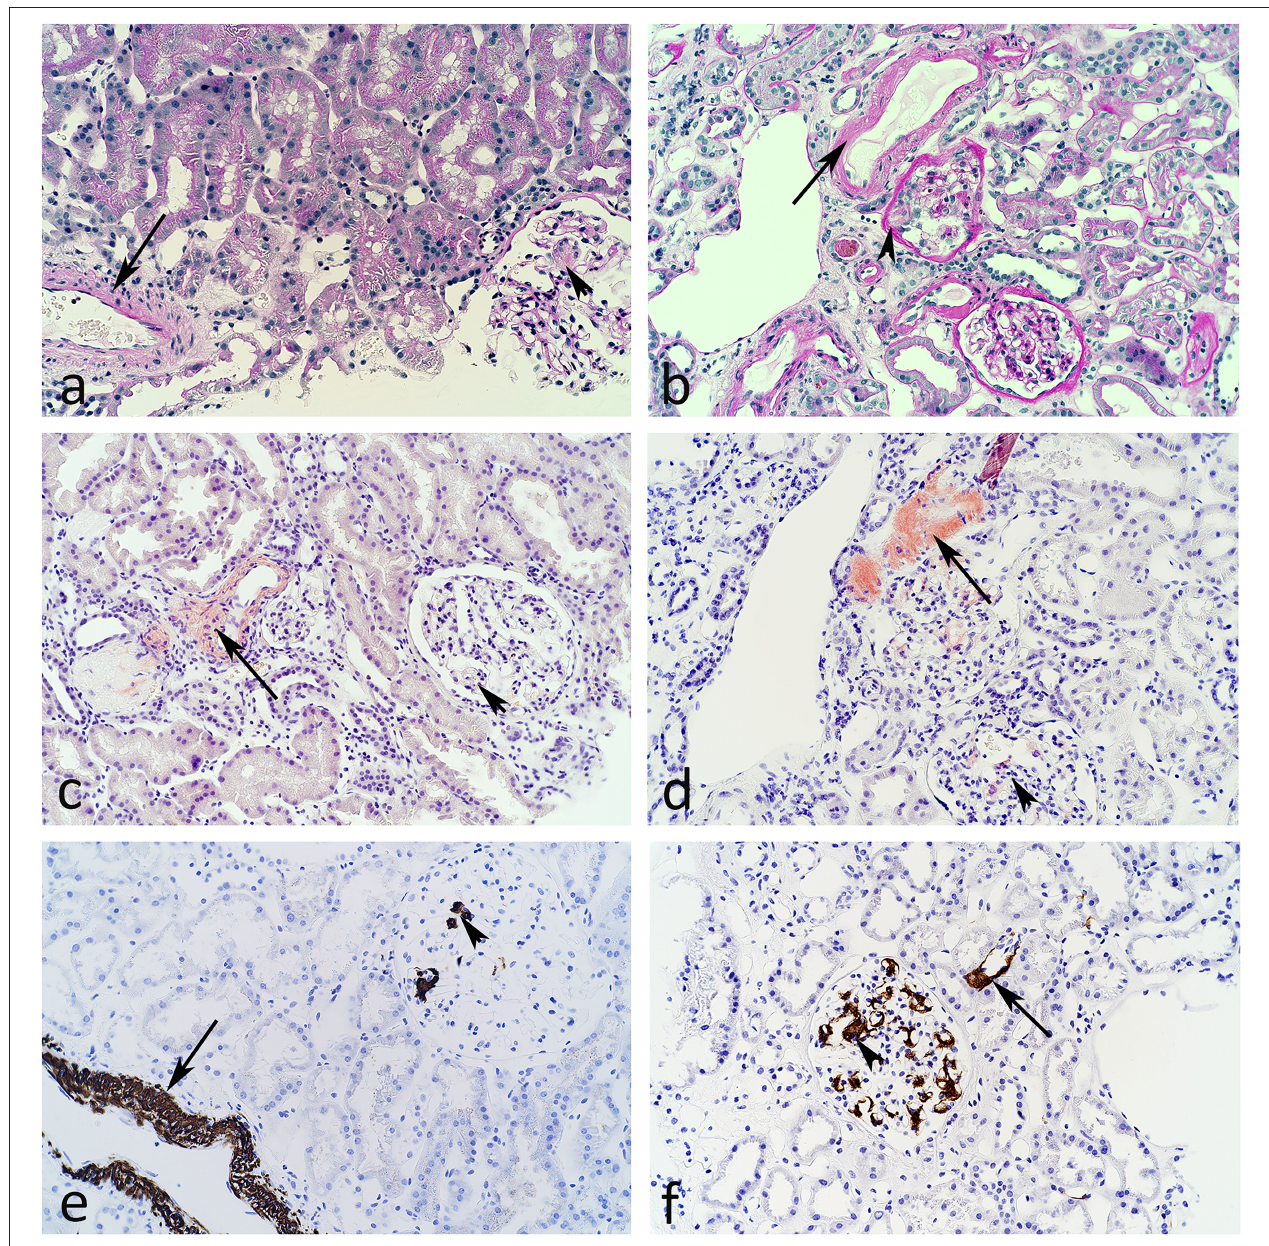
FIGURE 2 | Light microscopic images from the first (a,c,e) and the second (b,d,f) clinical case described. PAS stain (a,b) indicates deposition of minimal amorphous material in arteries (arrows) and a glomerulus (arrowhead) in panel (b) . Congo red stain (c,d) reveal amyloid in arteries (arrows) and focally in glomeruli (arrowhead). In addition, polarized light showed birefringence. Using antibodies against serum amyloid A (SAA) and immunoperoxidase staining (e,f) , the amyloid is identified as of SAA-type in glomeruli, arterioli, arteries, and interstitium.